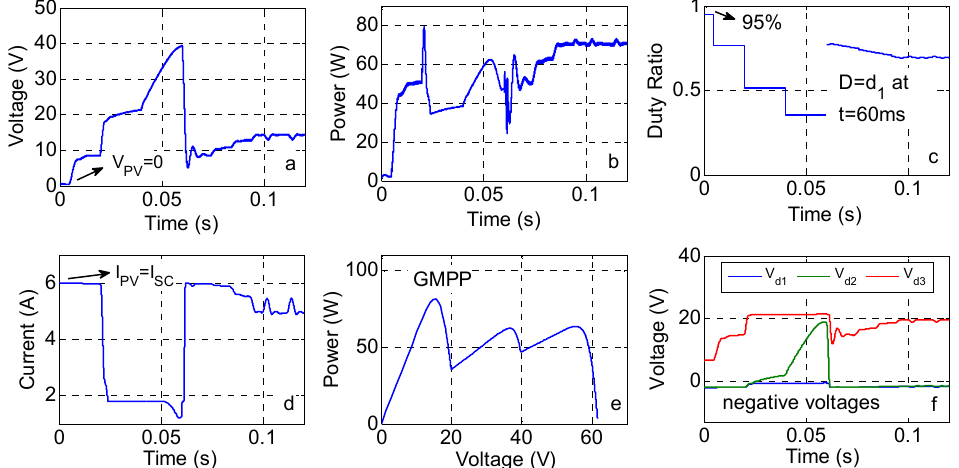
Figure 9. Case 1 ( a ) Voltage; ( b ) Power; ( c ) Duty Ratio; ( d ) Current; ( e ) P-V curve; and, ( f ) Voltage of bypass diode.